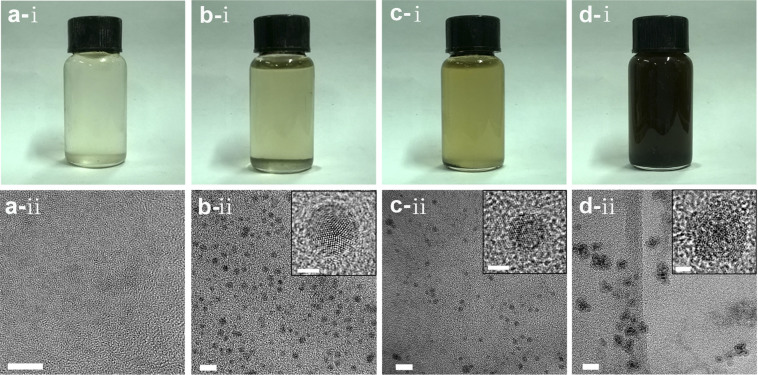
Reaction solution color change and TEM image of the resulted particle at different resident time in microfluidic channels after the reductant solution is mixed with the mixed metal salt solution using FeAl@Al(1-x)FexOy (the FeCl2 and AlCl3 in NMP shows yellow color) as example.Color changes of the reaction solutions (a-i, b-i, c-i and d-i) and TEM images of the formed nanoparticle (a-ii, b-ii, c-ii, d-ii) after the reaction proceeds about 0.39 s (Ltotal = 10 cm), 0.44 s (Ltotal = 15 cm), 1.03 s (Ltotal = 35 cm) and 1.77 s (Ltotal = 60 cm), respectively. Ltotal: the total microchannel length after the Y-mixer (5) in Fig. s1.